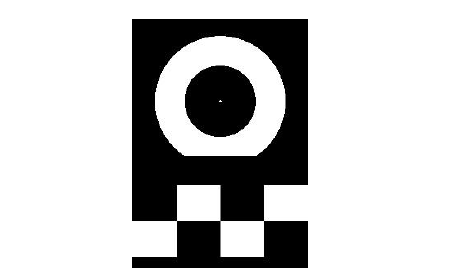
Figure 3. The design of the proposed coded